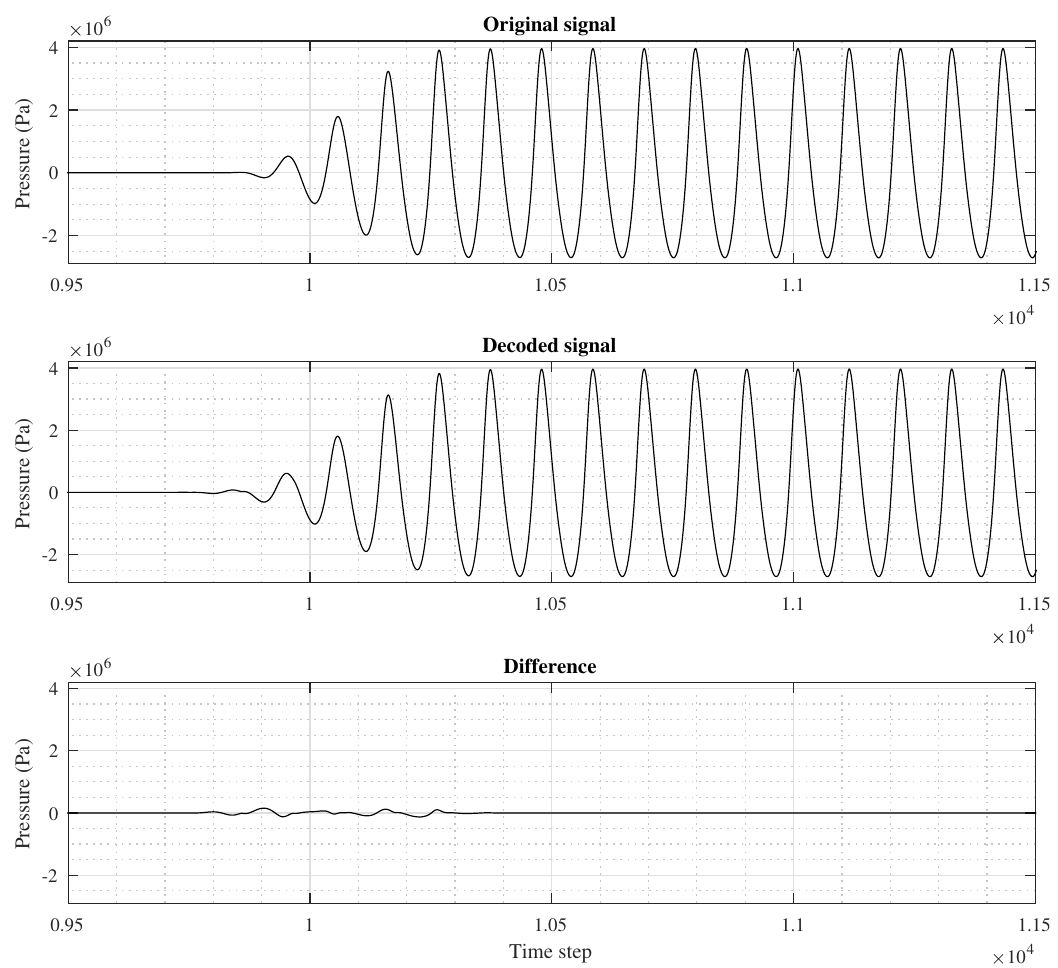
Figure 6. Illustration of the Non-linear 6 original, reconstructed, and difference signals with multiple of overlap size (MOS) equal to